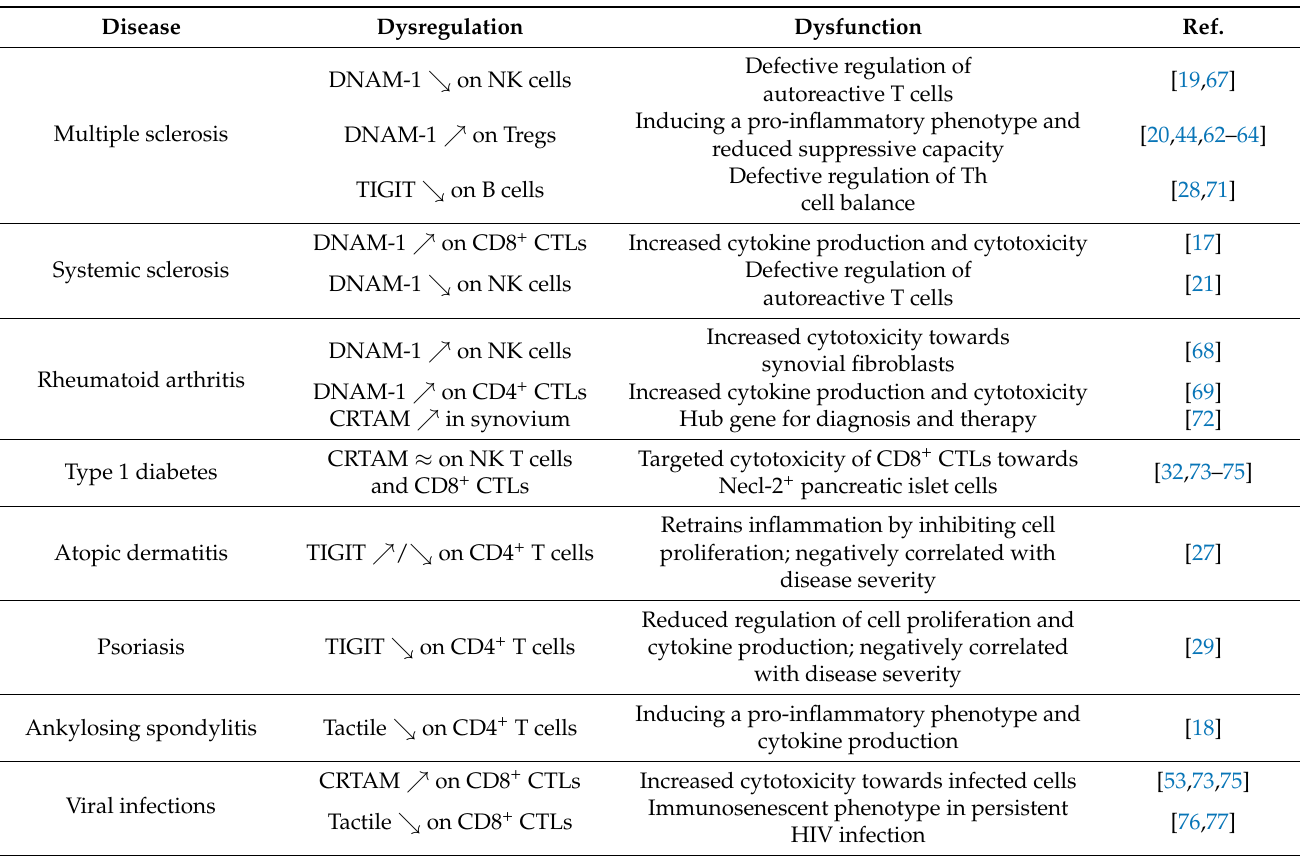
Table 2. Overview of dysregulated and dysfunctional DNAM-1, CRTAM, Tactile and TIGIT in autoimmunity and chronic inflammation. Dysregulated expression profiles are based on human data. CRTAM, class-I-restricted T-cell-associated molecule; CTL, cytotoxic T lymphocyte; DNAM-1, DNAX accessory molecule 1; HIV, human immunodeficiency virus; Necl-2, Nectin-like protein 2; NK, natural killer; Tactile, T-cell-activated increased late expression; TIGIT, T-cell immunoreceptor with Ig and ITIM domains; Treg, T-regulatory